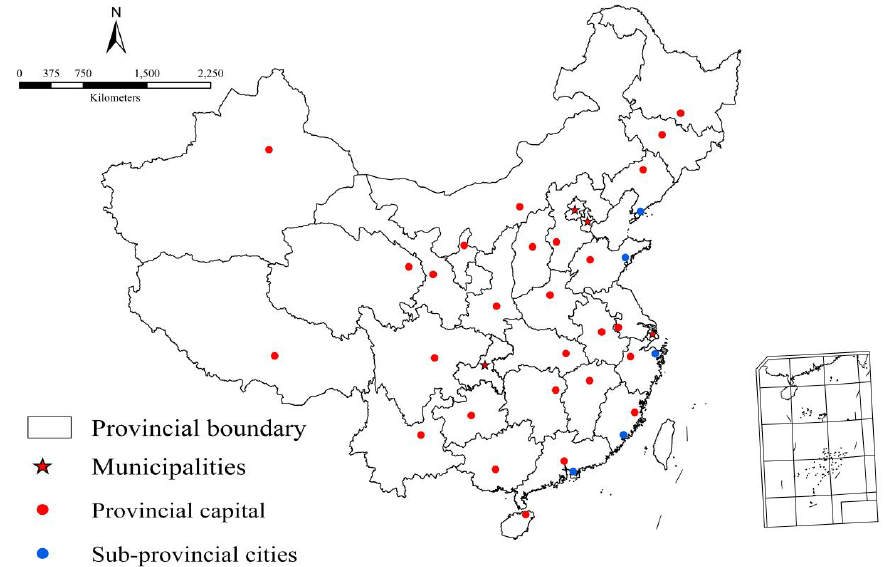
Figure 1. Geolocation of 36 key cities in China. The inset shows the islands in the South China Sea. Table 1. Description of 36 key cities [31] in